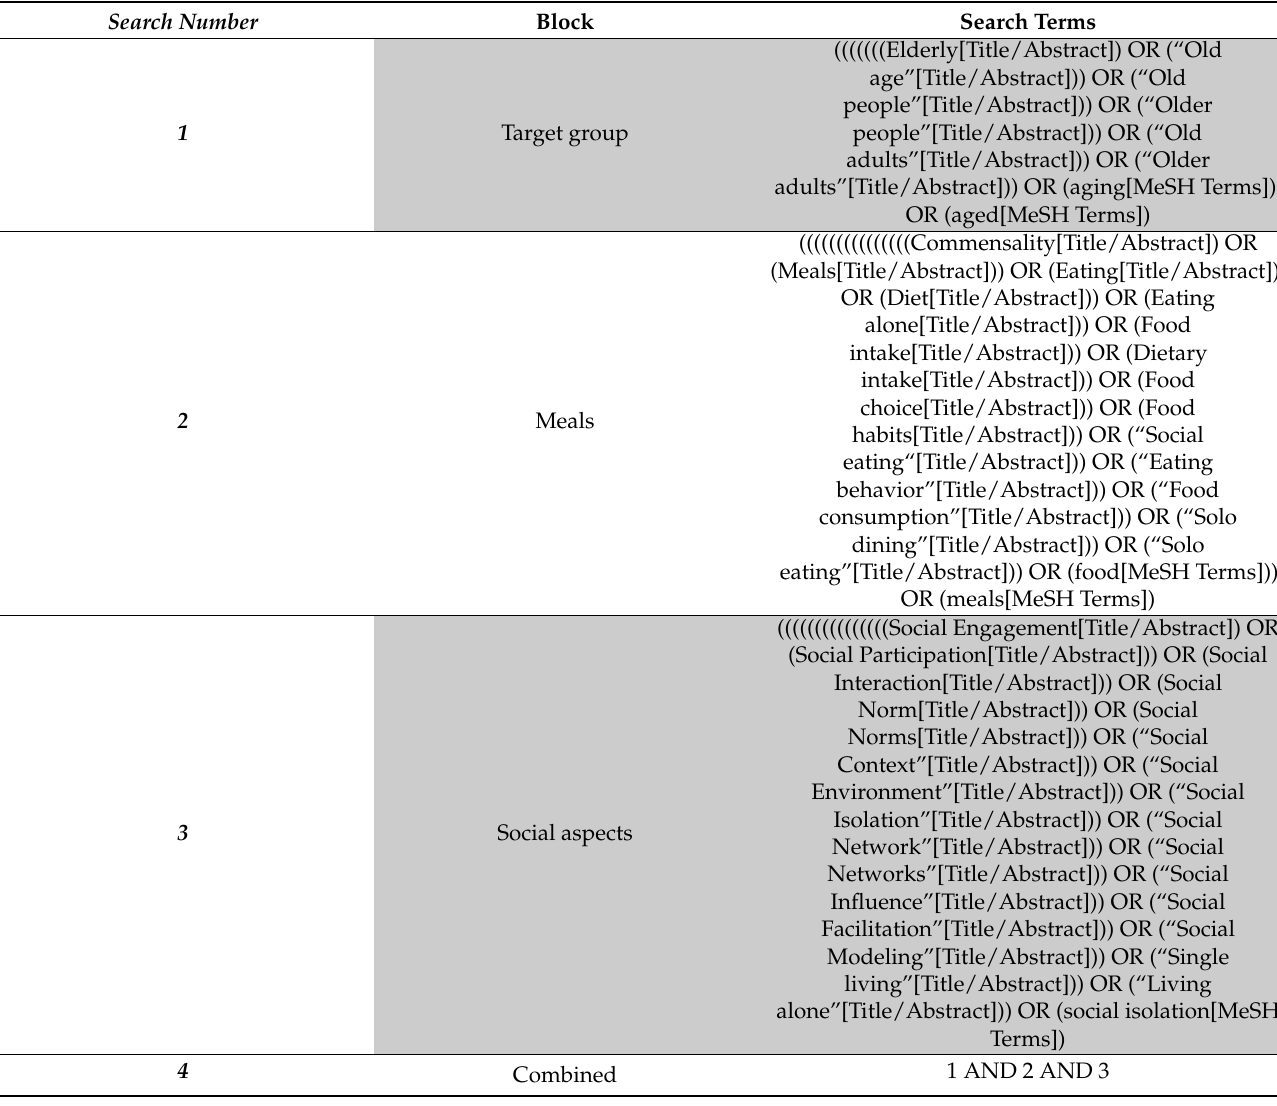
Table A2. Documentation of full electronic search strategy (Example from